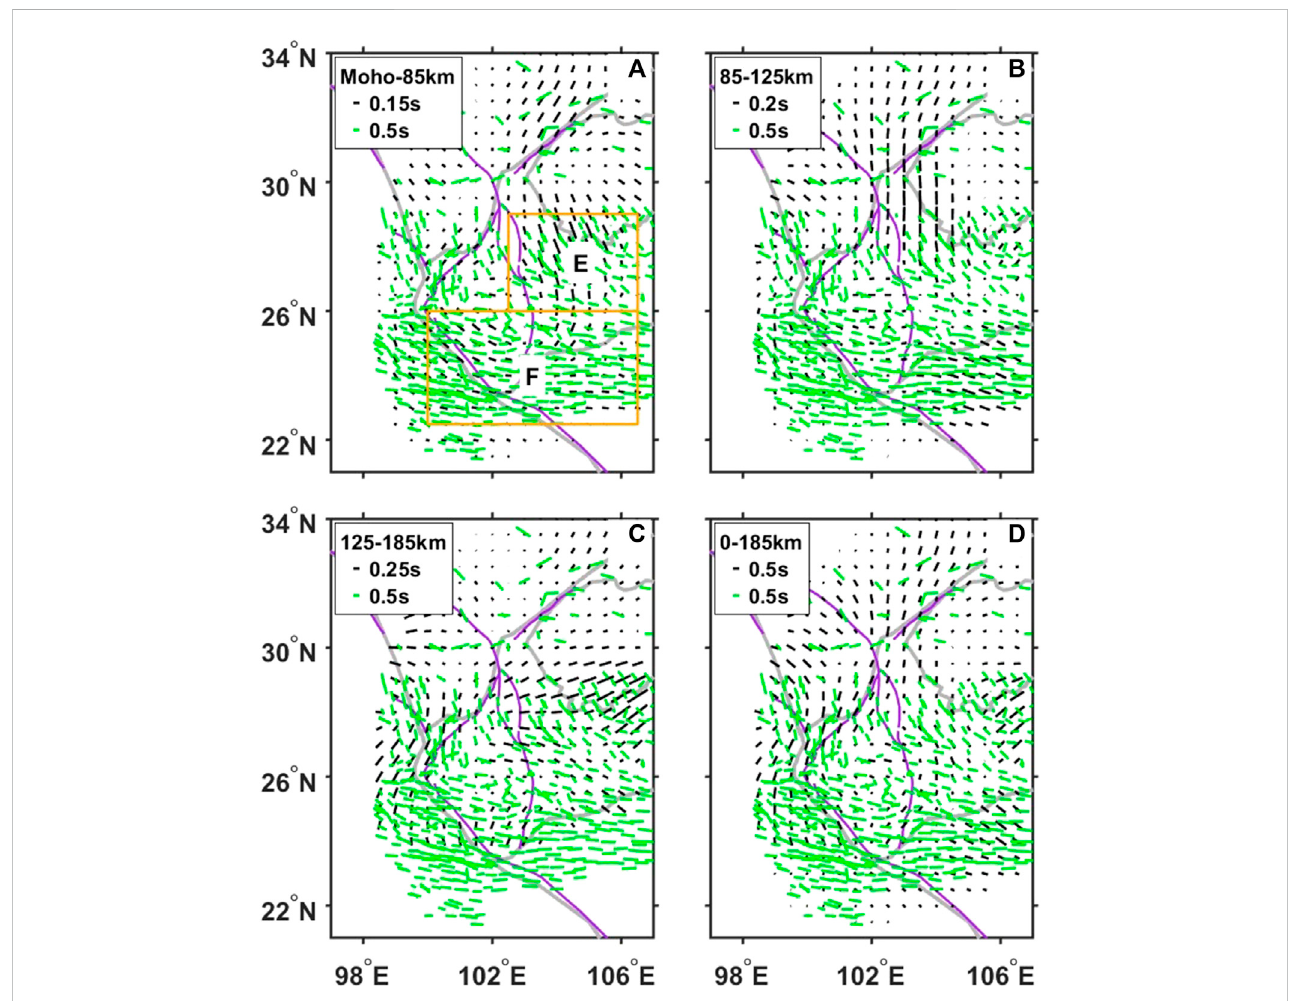
FIGURE 9 Same as Figure 7, but green bars represent the observed shear wave splitting parameters from the XKS phase data in (A – D)